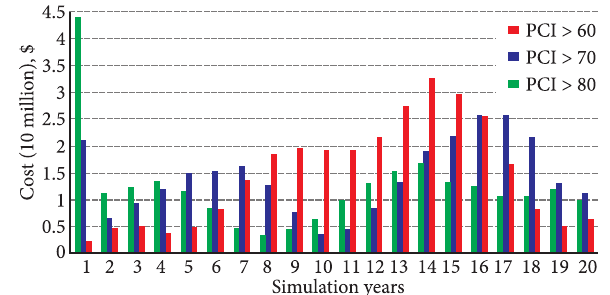
Fig. 10. Annual costs for Scenarios #2, #3, and #4